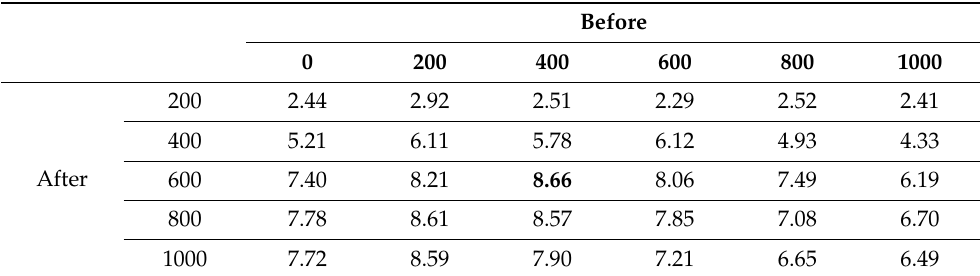
Table 5. The perceived naturalness of the female model. The bold text with a large font means the highest